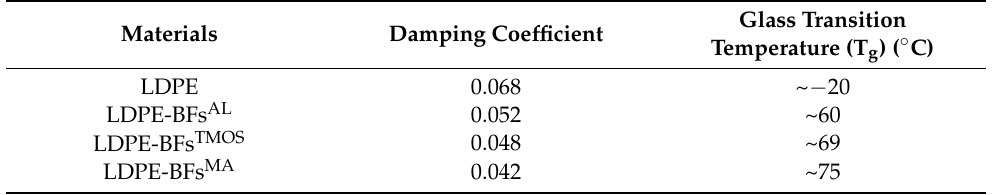
Table 1. Damping coefficient and glass transition temperature of neat LDPE and the LDPE-BFs composites